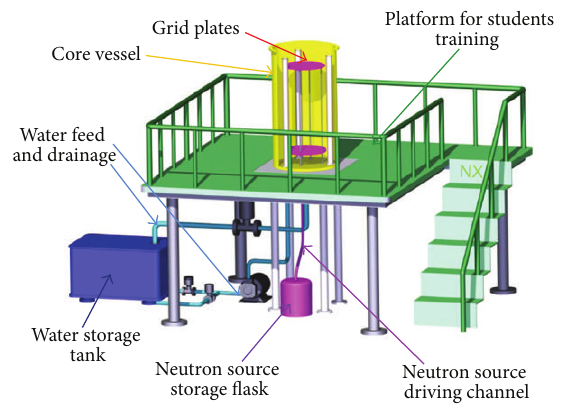
Figure 2: Layout design of JSA main